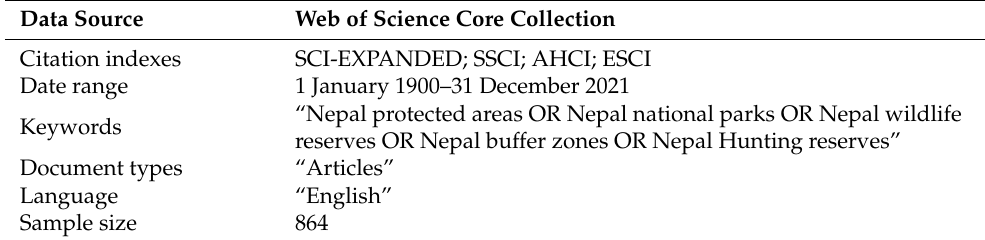
Table 1. A summary of searching